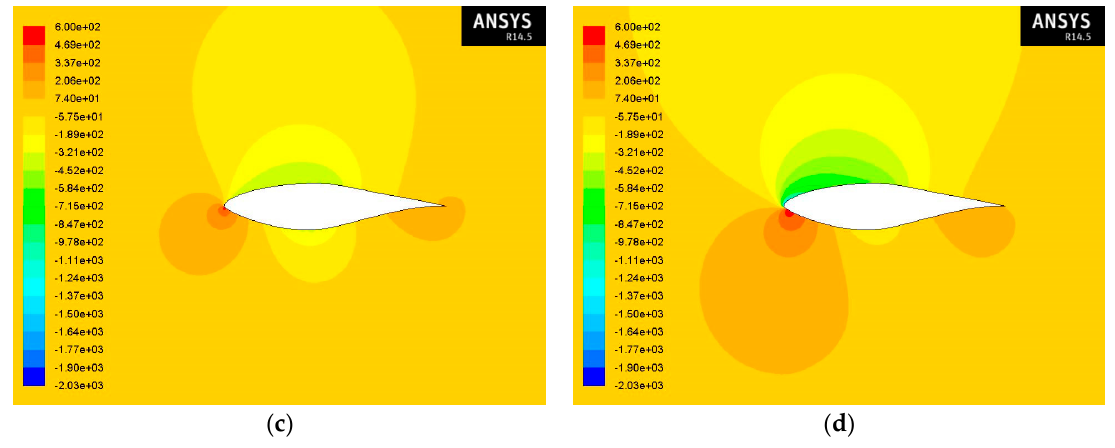
Figure 12. Contours of static pressure at ( a ) − 3°; ( b ) 0°; ( c ) 3°; and ( d ) 9° angles of attack at Re = 2 × 10 6 with the realizable k– ε turbulence model for an S809 airfoil for air-sand particle two-phase flow and 10% concentration of sand particles in the air.